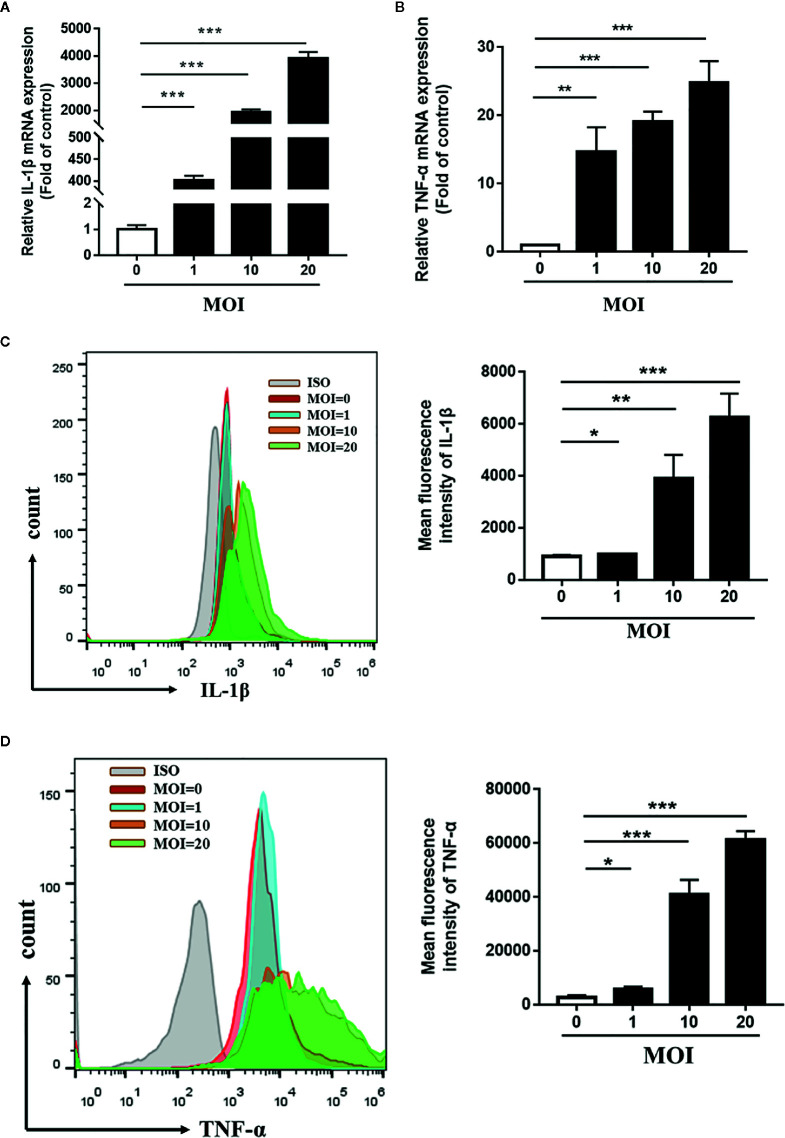

Tp-induced expression of IL-1β and TNF-α in THP-1 cells. THP-1 cells were incubated with Tp at different MOIs for 12 h. The mRNA expression of IL-1β and TNF-α was evaluated by RT-PCR (A, B). The protein expression of IL-1β and TNF-α was evaluated by flow cytometry (C, D). (*P < 0.05; **P < 0.01; ***P < 0.001). MOI, multiplicity of infection.